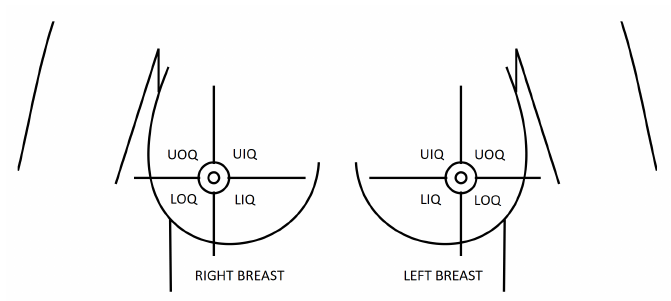
Figure 4. Breast quadrants definition: Upper-Outer (UOQ), Upper-Inner (UIQ), Lower-Outer (LOQ), Lower-Inner (LIQ) quadrants - adapted from (https://commons.wikimedia.org).